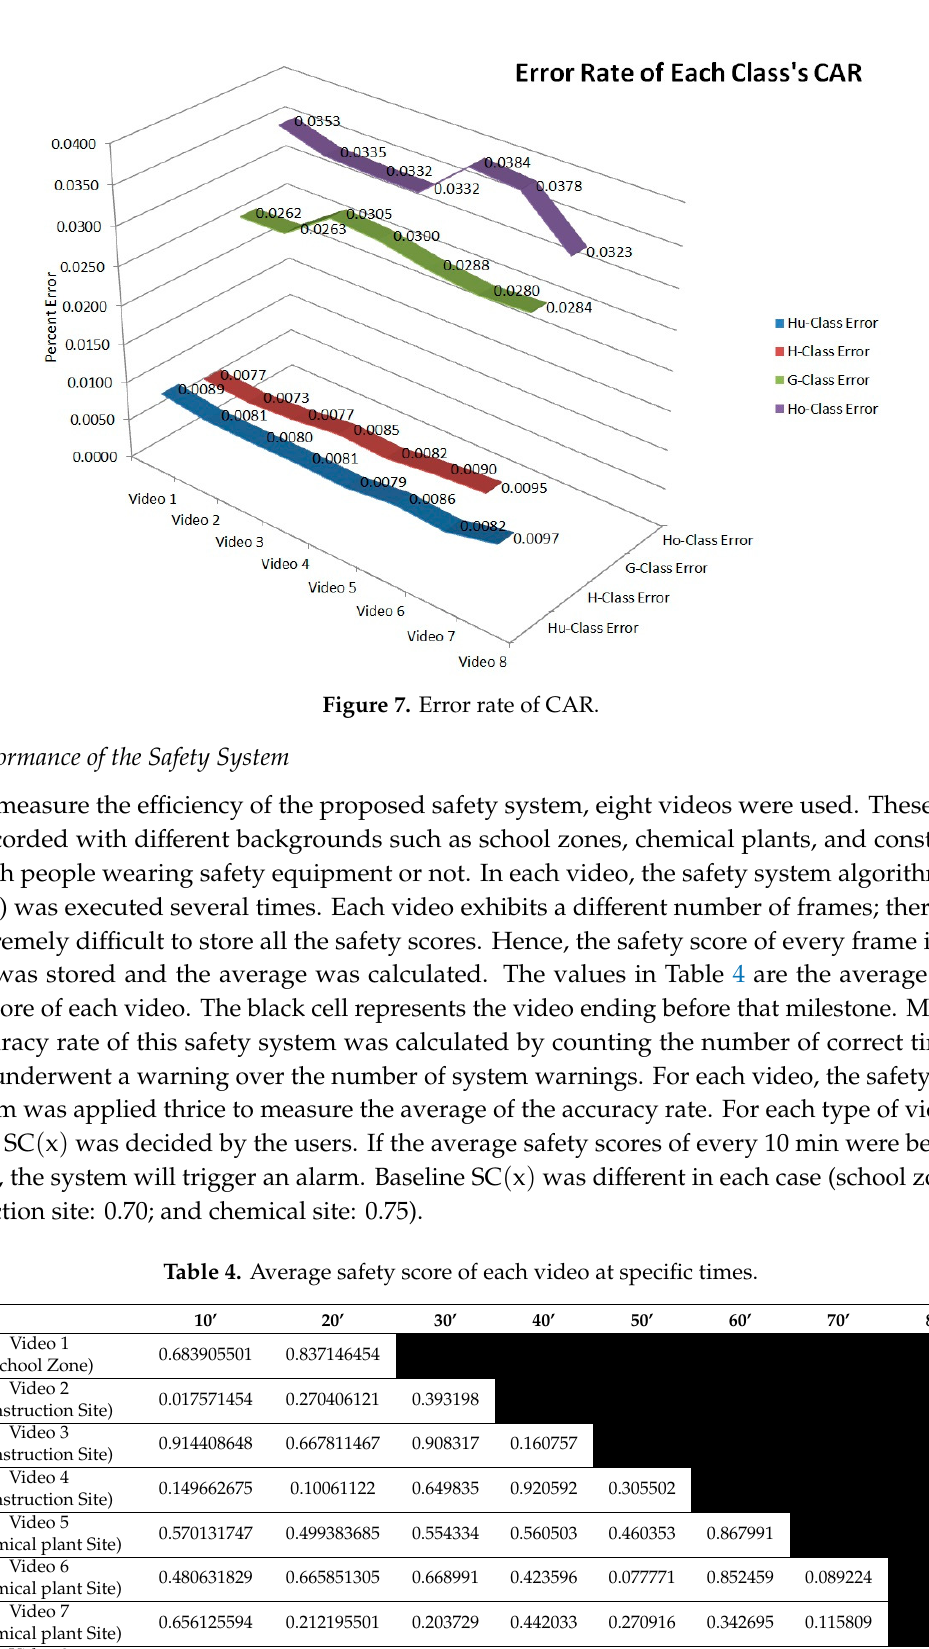
Figure 6. Classification rate of each class.